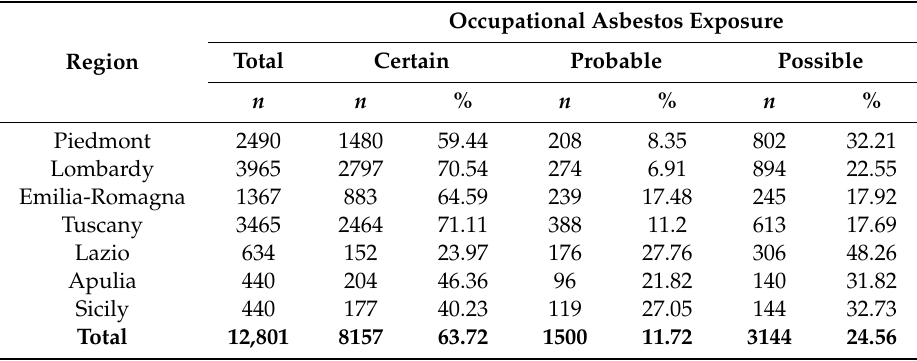
Table 2. Distribution of occupational asbestos exposure levels by